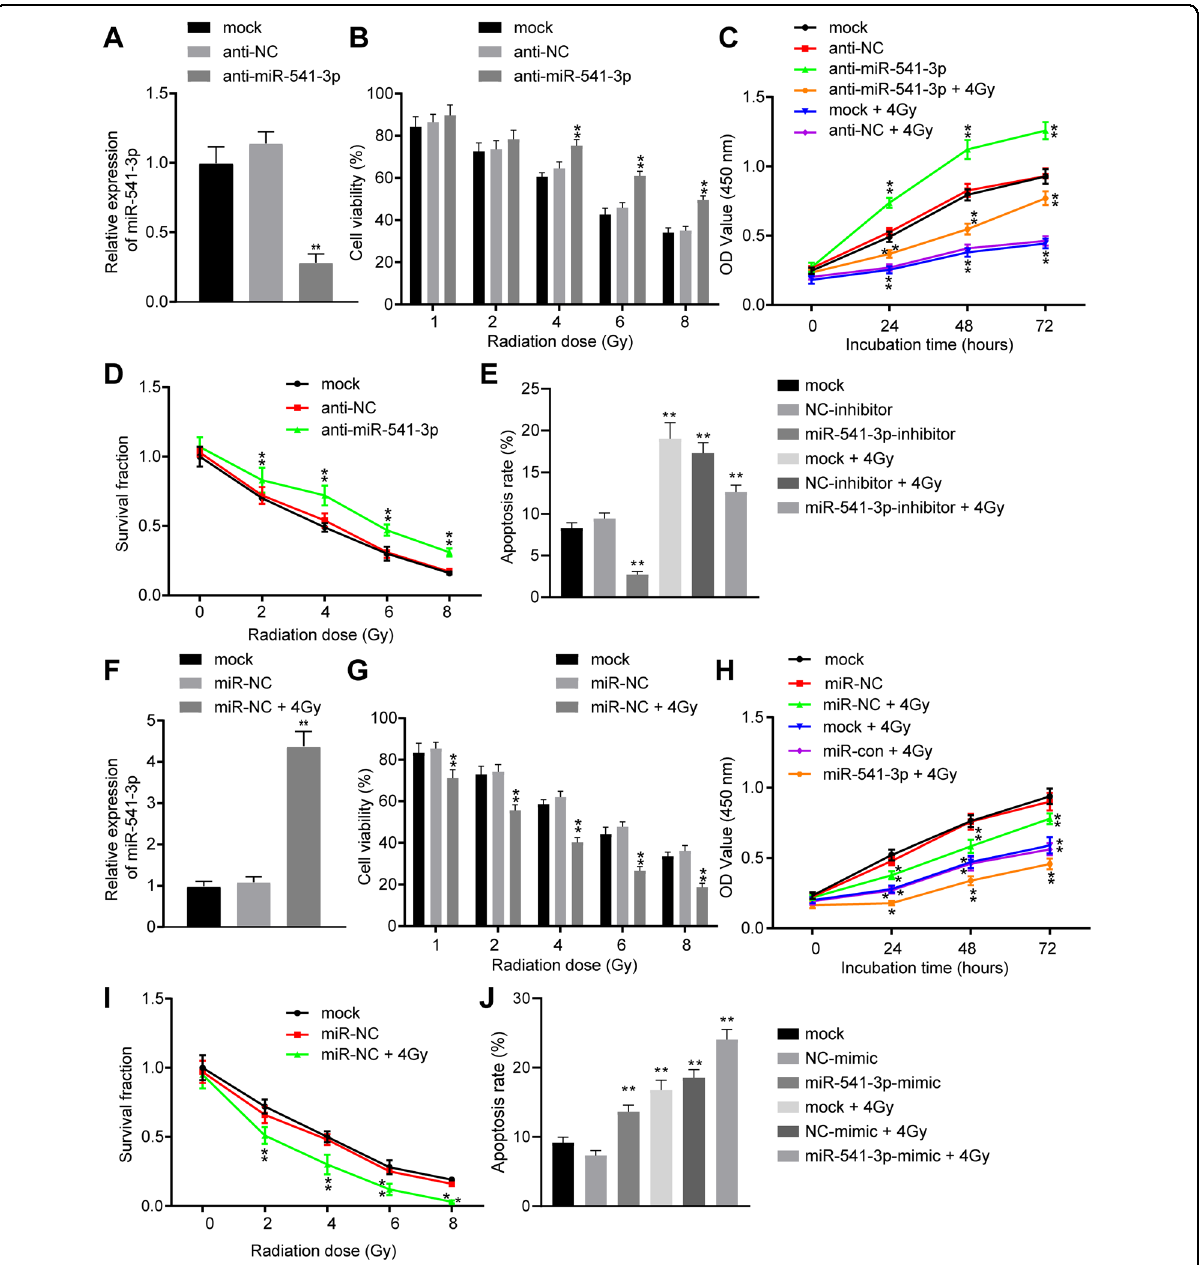
Fig. 2 Elevation of miR-541-3p increases the radiosensitivity of LNCaP cells. A Expression level of miR-541-3p in LNCaP cells transfected with anti-miR-541-3p or anti-NC determined by RT-qPCR. B The viability of LNCaP cells after inhibition of miR-541-3p. C LNCaP cell proliferation after inhibition of miR-541-3p detected by CCK-8. D Radiosensitivity of LNCaP cells after miR-541-3p inhibition. E LNCaP cell apoptosis after inhibition of miR-541-3p and radiation assessed by fl ow cytometry. F Expression level of miR-541-3p in LNCaP cells after transfection with miR-541-3p mimic or miR-NC. G Detection of the viability of LNCaP cells after X-ray radiation and overexpressing miR-541-3p. H The proliferation of LNCaP cells after X-ray radiation and overexpression of miR-541-3p. I Colony formation ability of LNCaP cells after X-ray radiation and overexpression of miR-541-3p. J Cell apoptosis after X-ray radiation and overexpression of miR-541-3p. Values were mean ± expressed as SEM ( n = 3), one-way ANOVA was used for comparison between groups, and two-way ANOVA was used for cell viability at different time points. Compared with the control group, * p < 0.05 and ** p <